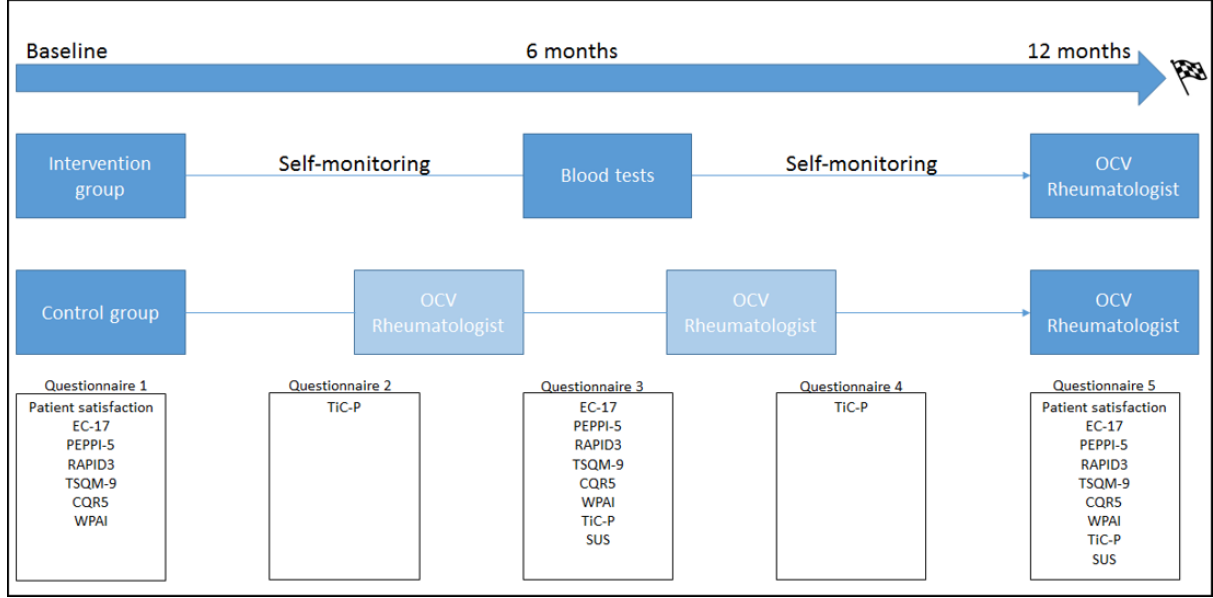
Figure 5. Study design and outcomes over time. The control group continues regular care, usually with two or three preplanned outpatient clinic visits (OCVs) (light blue box). The intervention group has only one preplanned OCV (blue box) and monitors symptoms using a smartphone app. All patients complete five questionnaires during the study to compare secondary outcomes. CQR5: Compliance Questionnaire for Rheumatology 5; EC-17: Effective Consumer Scale 17; PEPPI-5: 5-item Perceived Efficacy in Patient-Physician Interactions; RAPID3: Routine Assessment of Patient Index Data 3; SUS: System Usability Scale; TiC-P: Treatment Inventory of Costs in Psychiatric Patients; TSQM-9: Treatment Satisfaction Questionnaire for Medication 9; WPAI: Work Productivity and Activity